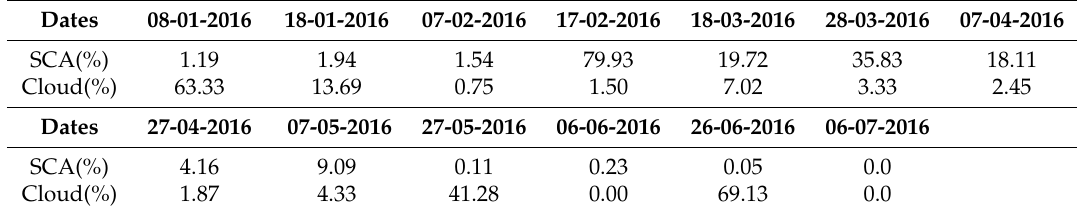
Table 1. Acquisition dates of Sentinel-2 snow products and fraction of the Rheraya catchment covered by snow and clouds.